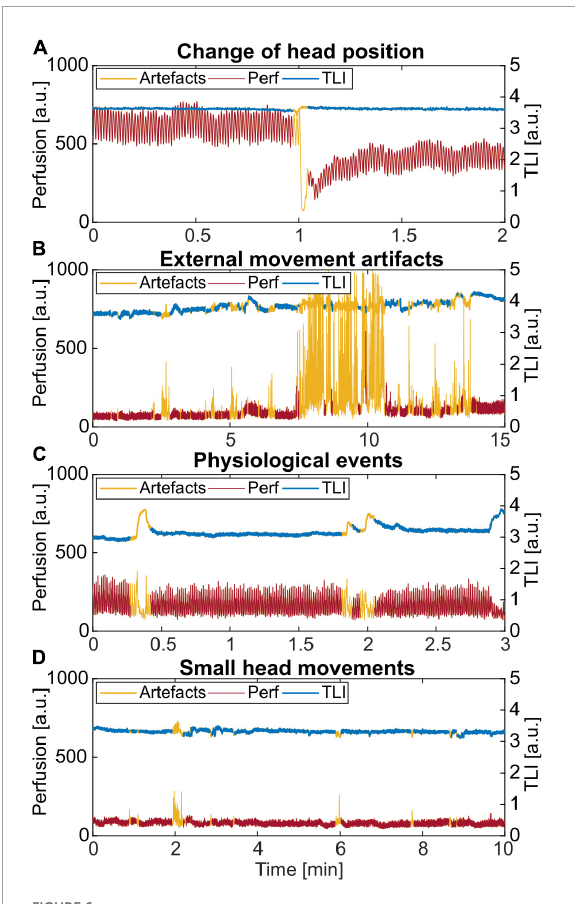
FIGURE6 Examples of different artifacts identified by thresholding the time-resolved wavelet energy in the 0.5–0.6 Hz frequency band. (A) Change of the head position. (B) External movement from nursing and care of the patient. (C) An unknown physiological pattern. (D) Small spikes caused by involuntary head movements by the patient. Only the artifact at minute 2 was noted in the